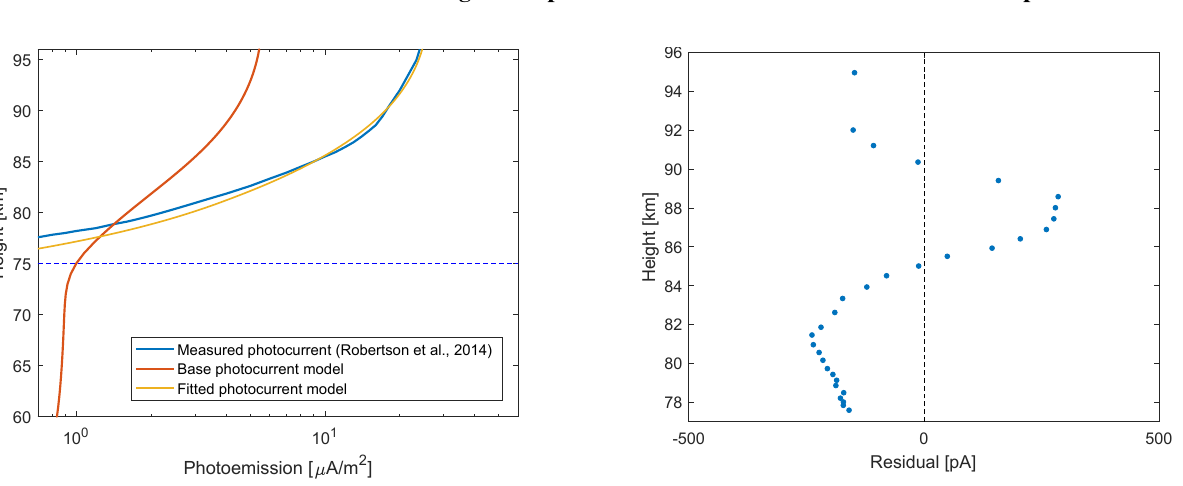
Figure 10. Photocurrent measurements from a 20mm diameter alu- minium plate, taken from Robertson et al. (2014) (blue curve), com- pared to the computed photocurrent by the base model (red curve) and the model with adjusted yield and + 1 . 2km shift in altitude (yel- low curve). The horizontal dashed line shows the lower height limit for the expected MSP layer. The solar zenith angle considered for the calculation is 75 ◦ .